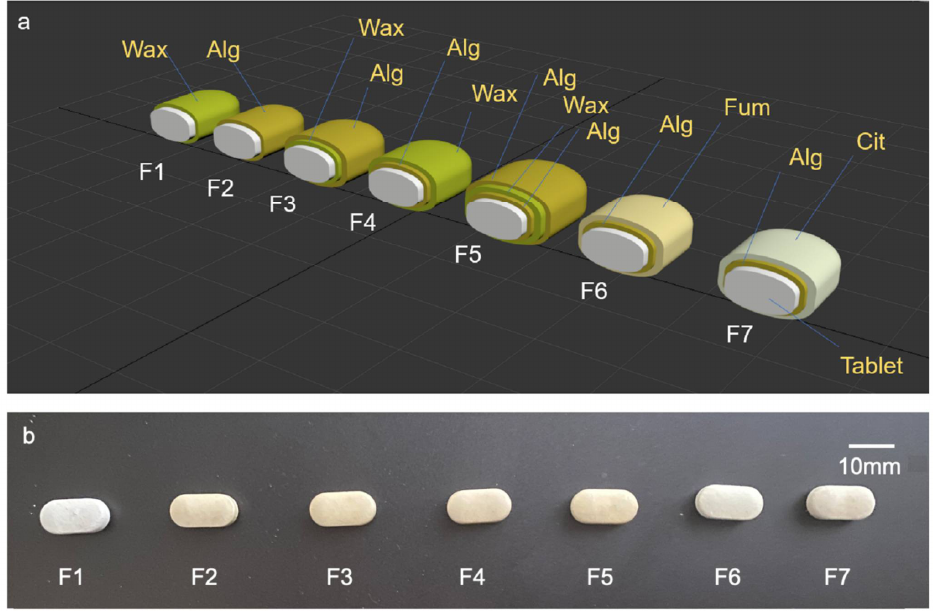
Figure 1. ( a ) Schematic diagram and ( b ) photographs of different natural coating